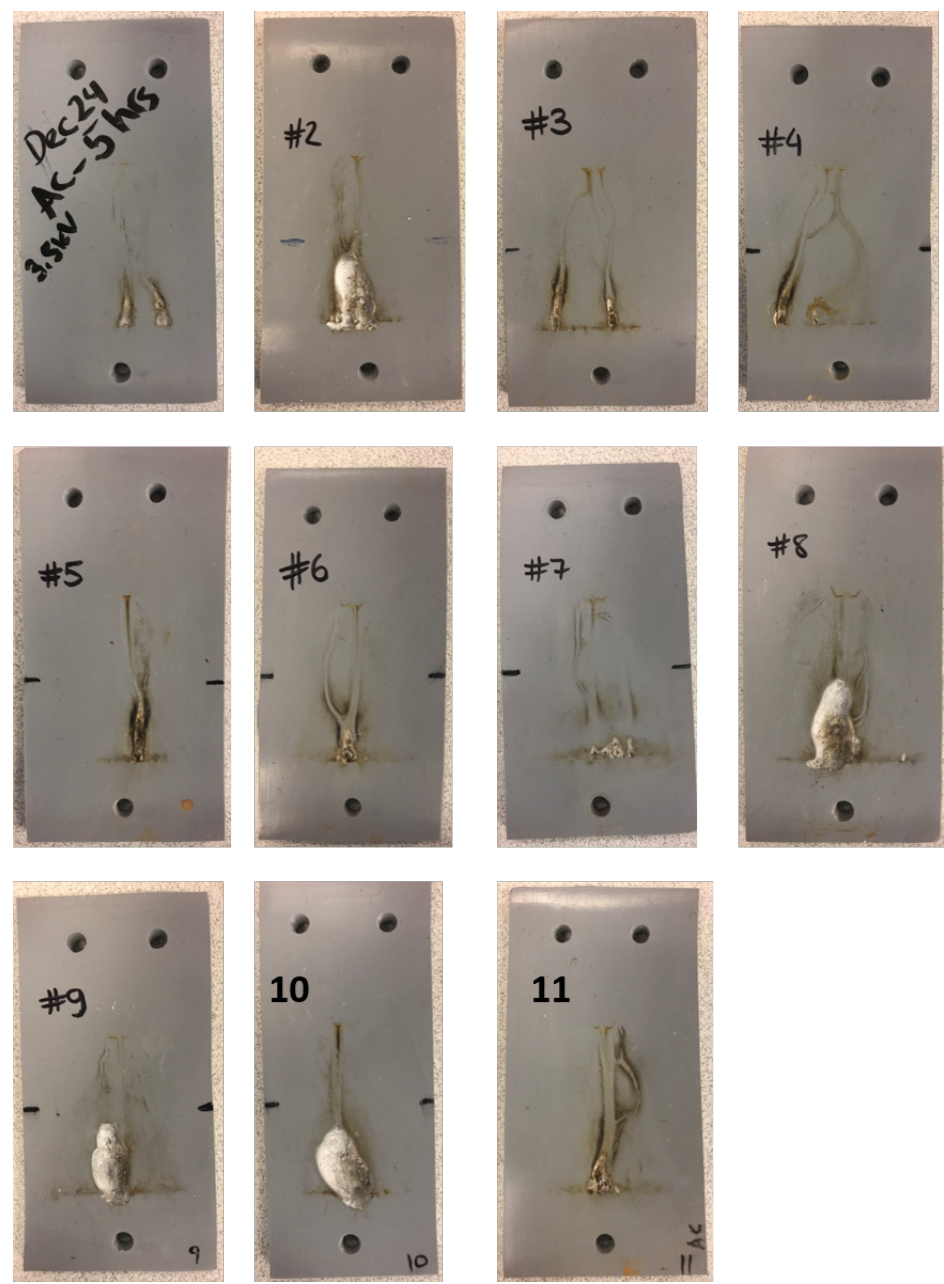
Figure A1. Photographs of test specimens #1–#11 at the end of AC